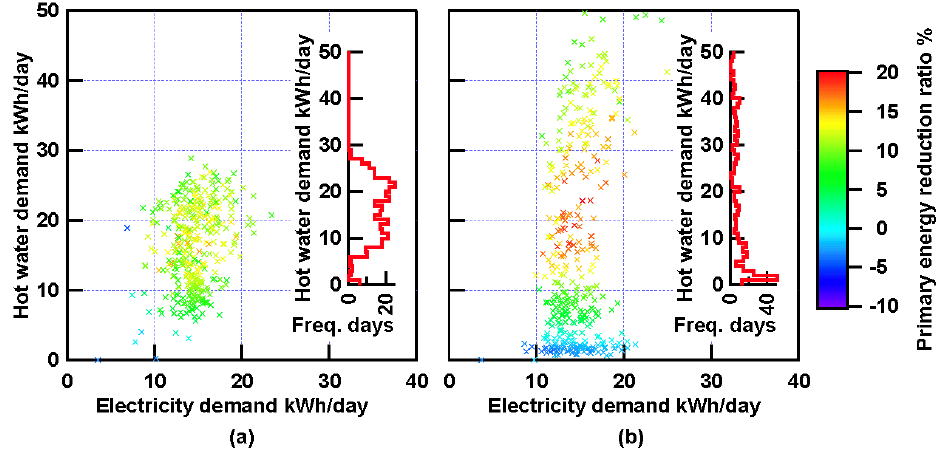
Figure 8. Daily primary energy reduction ratio. ( a ) House A; ( b ) House B.